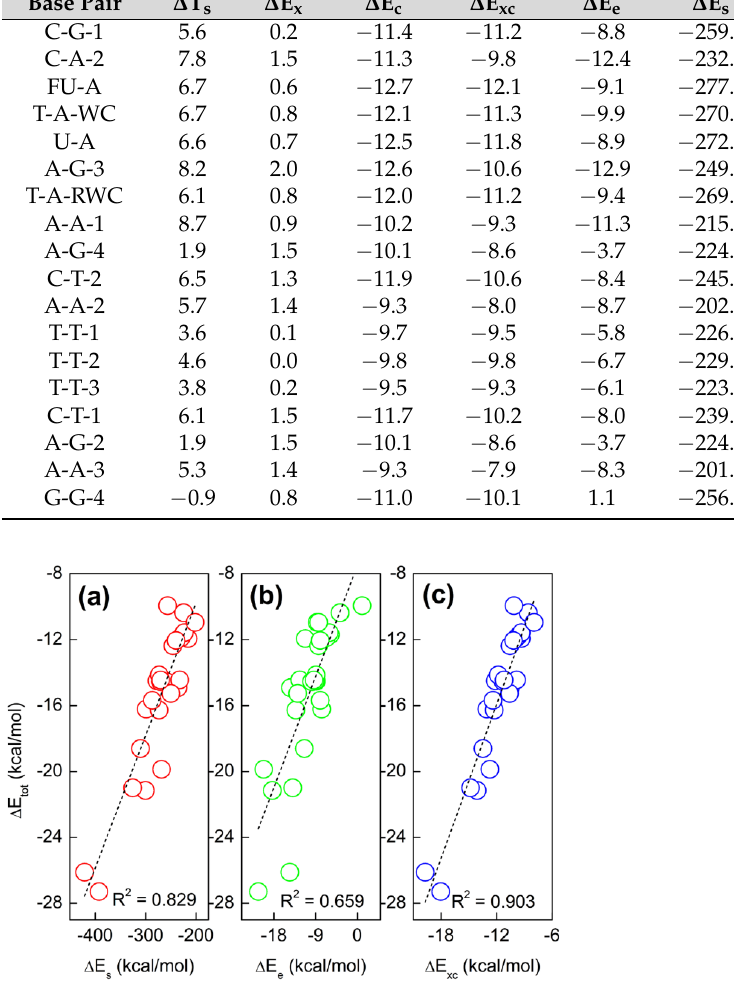
Figure 1. Strong correlations between the total energy difference ( Δ E tot ) and ( a ) steric hindrance ( Δ E s ), ( b ) electrostatic potential ( Δ E e ), and ( c ) exchange-correlation effect ( Δ E xc ). The y -axis of ( a ) spans to ( b , c ).